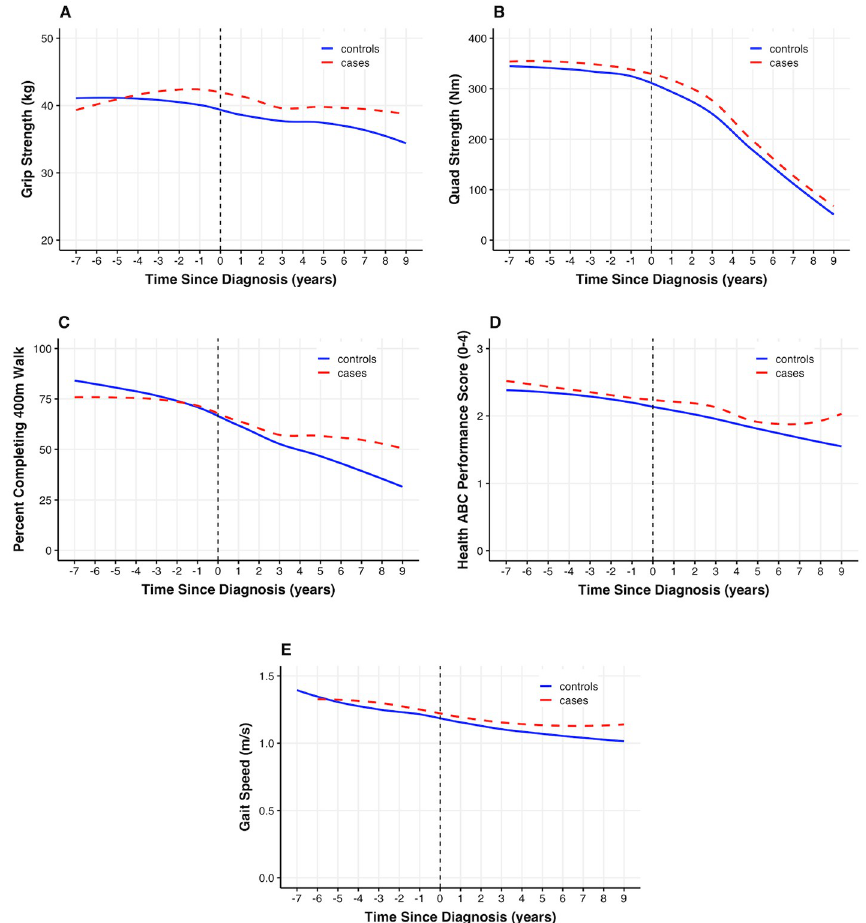
Fig 2. Strength and physical function trajectories. Loess regression models depicting trajectories of strength and physical function among cancer cases and controls.